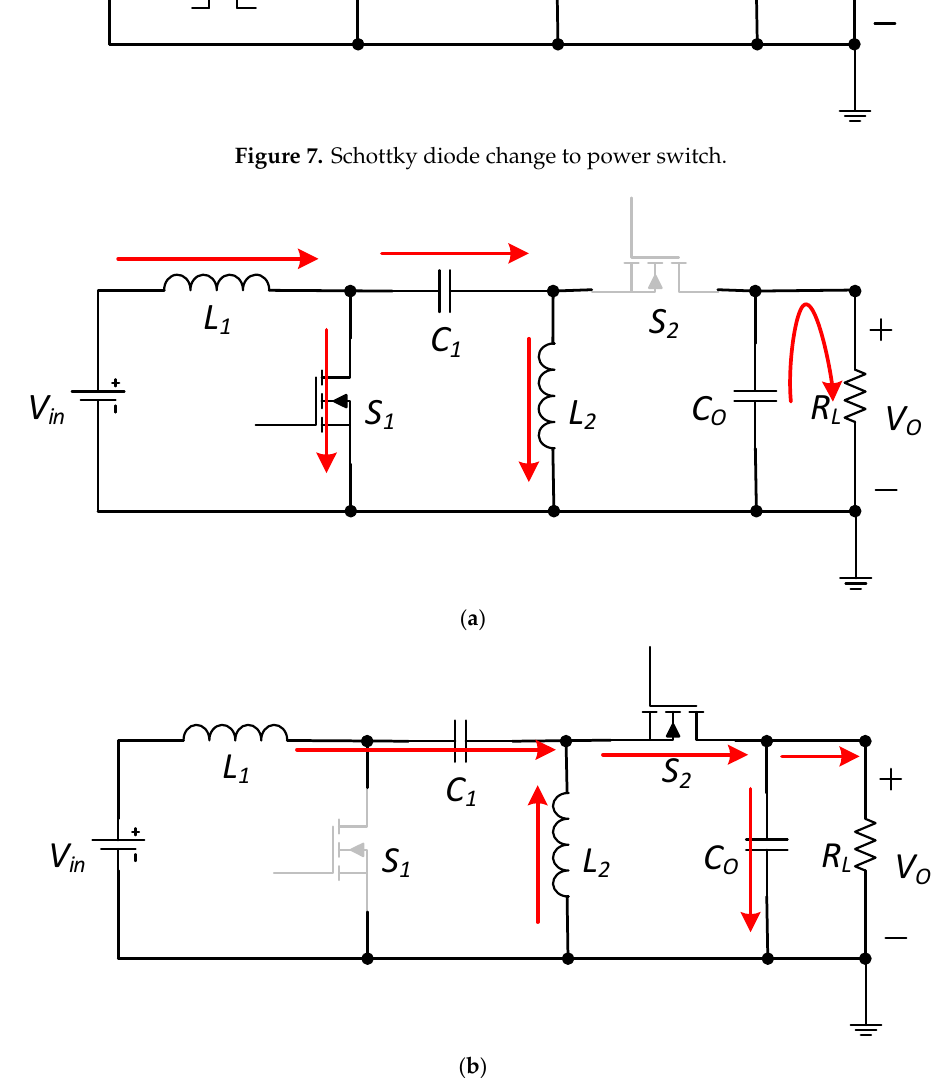
ff ; ( b ) S ff , S 1 is o 2 is